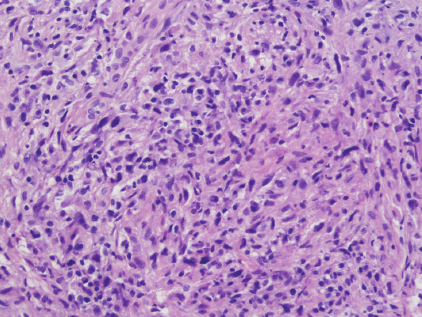
Figure 5: Biopsy of lung nodule revealed a sarcoma comprised of high grade spindle-shaped cells, consistent with metastatic sarcoma (hematoxylin and eosin stain, 20x).